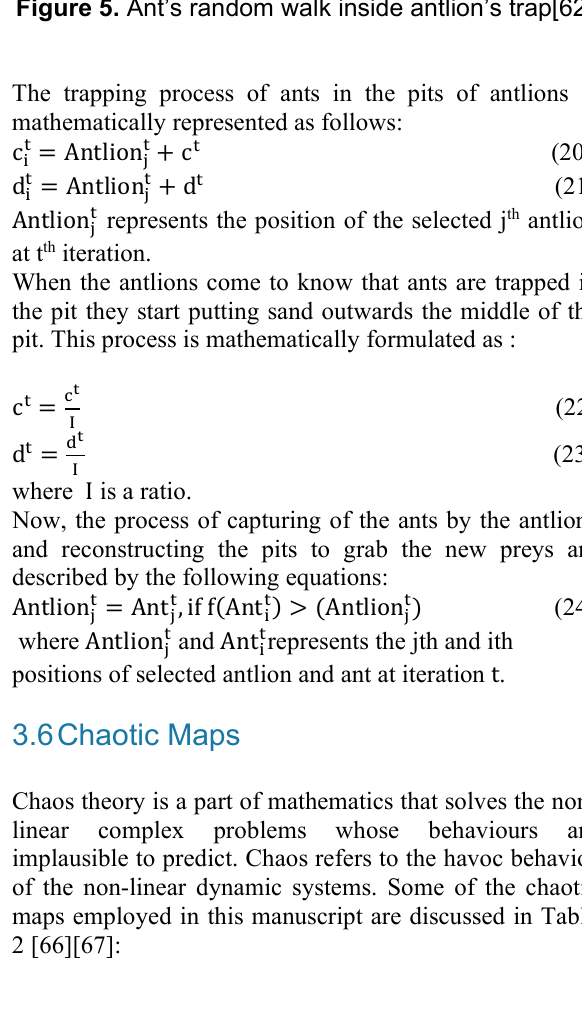
Figure 5. Ant’s random walk inside antlion’s